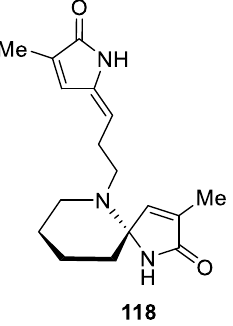
Figure 55. Alkaloid ( ± )-pandamarine isolated from Pandanus amaryllif olius .